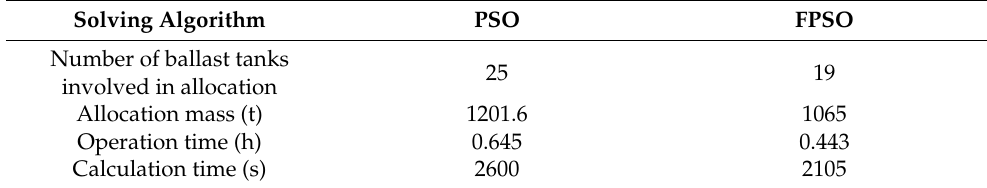
( b ) Figure 22. Allocation schemes solved by different algorithms. ( a ) PSO algorithm. ( b ) FPSO algorithm. From Figure 22 and Table 6, it can be observed that compared to the PSO algorithm, the operation efficiency of the allocation scheme obtained by FPSO increases by 31%; the calculation time reduces by 19%; and the number of ballast tanks involved in the alloca- tion reduces by 24%. This indicates that the FPSO algorithm improves the solving quality of the allocation scheme. Moreover, with the increase in the number of ballast tanks, the